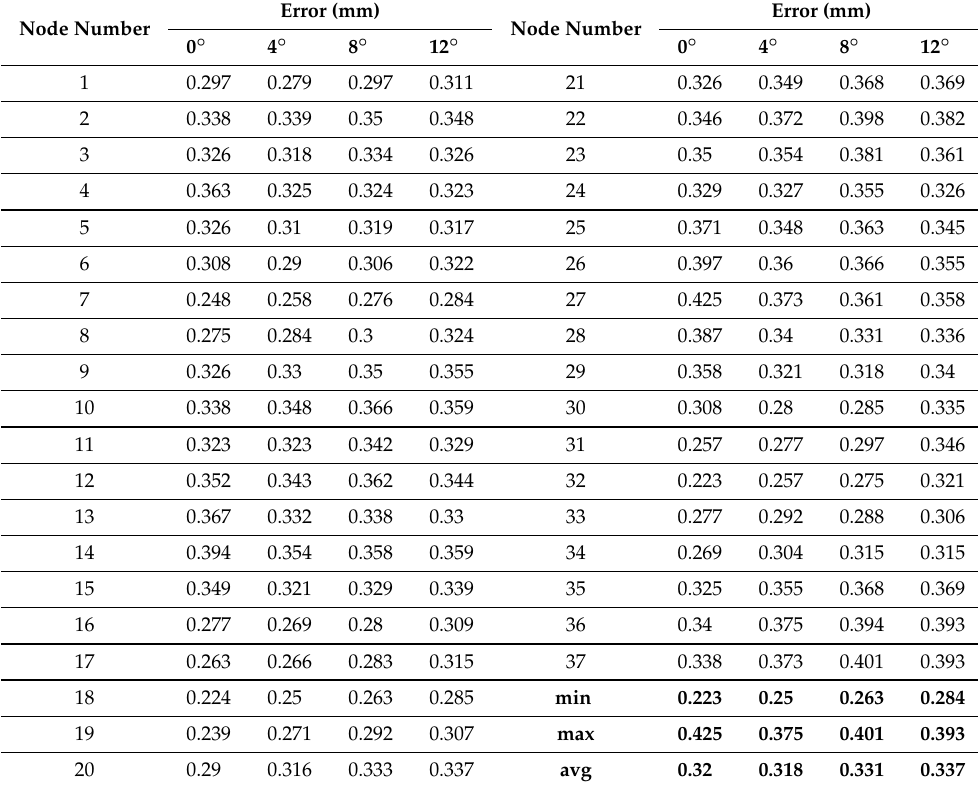
Table 3. Error between simulation and experiment for all the